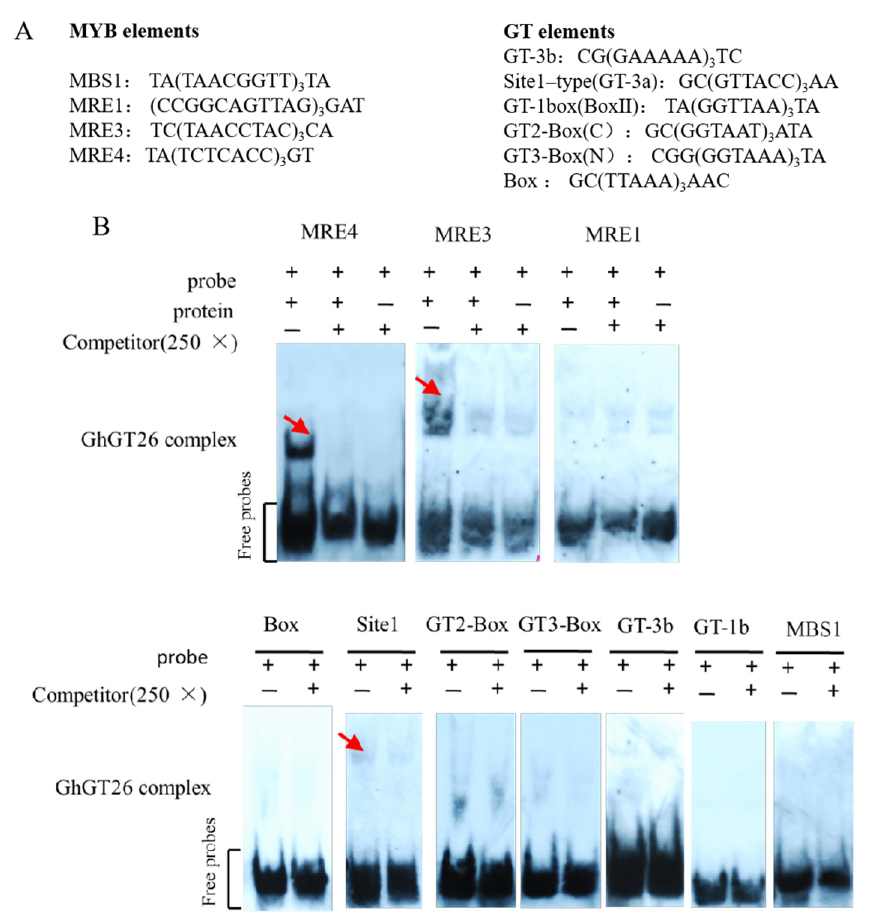
Figure 7. DNA binding ability of GhGT26. ( A ) The elements used for the GhGT26 protein binding assay. ( B ) GhGT26 was expressed and subjected to a gel-shift assay. The red arrow indicates the positions of a protein/DNA complex.